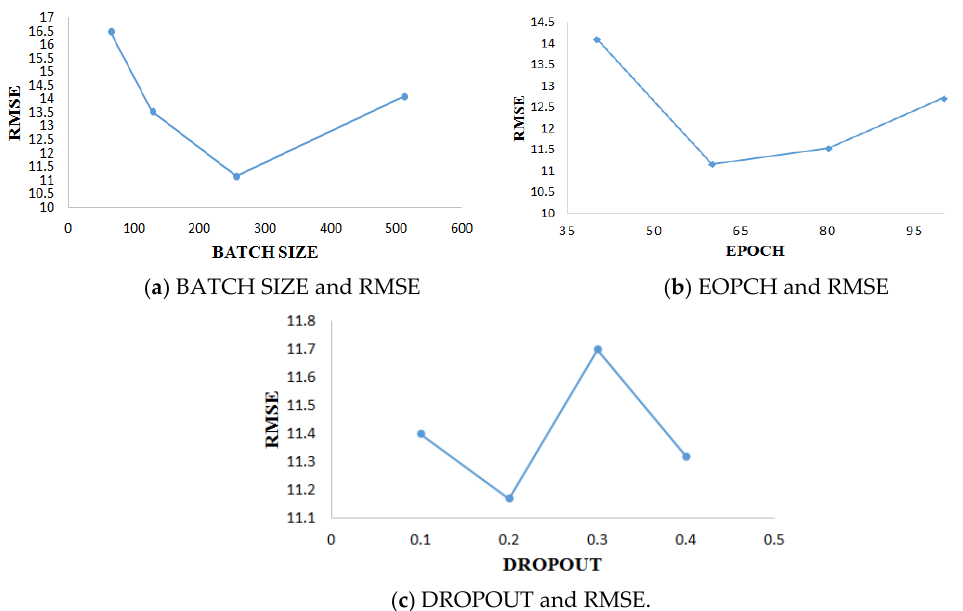
Figure 10. Experimental results of different parameters of FD001.